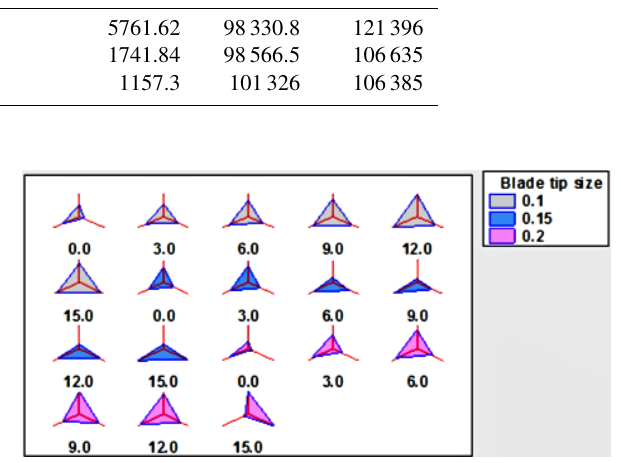
Figure 14. Normal force for blade tip sizes of 0.1, 0.15, and 0.2m with blade twist angles of 0, 3, 6, 9, 12, and 15 ◦ for three airfoils is shown.